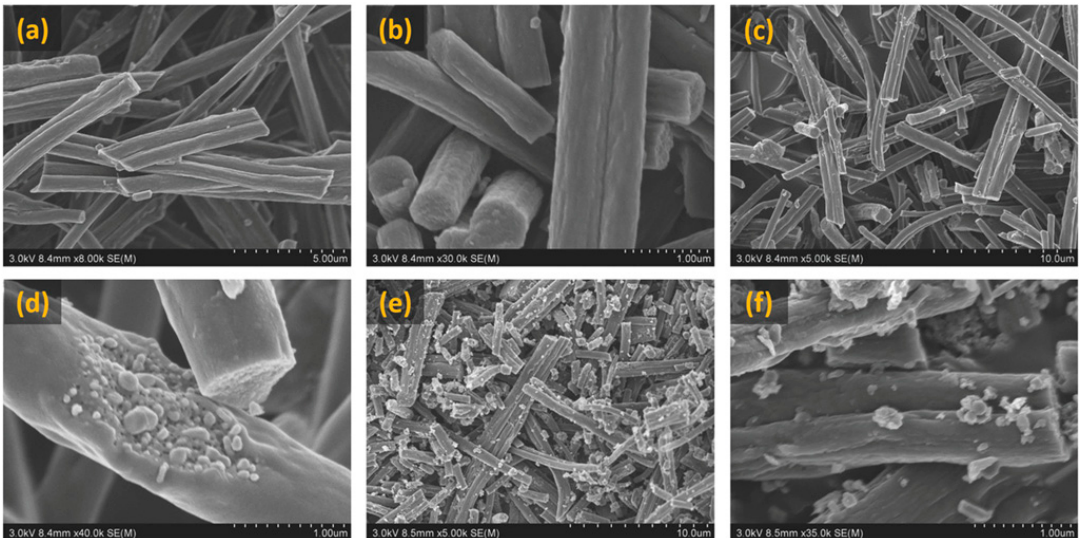
Figure 10. FESEM images showing NiCoP / CNF sample carbonized at 700, 800, 900 ◦ C: ( a , b ) NiCoP / CNF carbonized at 700 ◦ C, ( c , d ) NiCoP / CNF carbonized at 800 ◦ C and ( e , f ) NiCoP / CNF carbonized at 900 ◦ C. Reproduced with permission from Ref. [116]. Copyright John Wiley and Sons 2018.